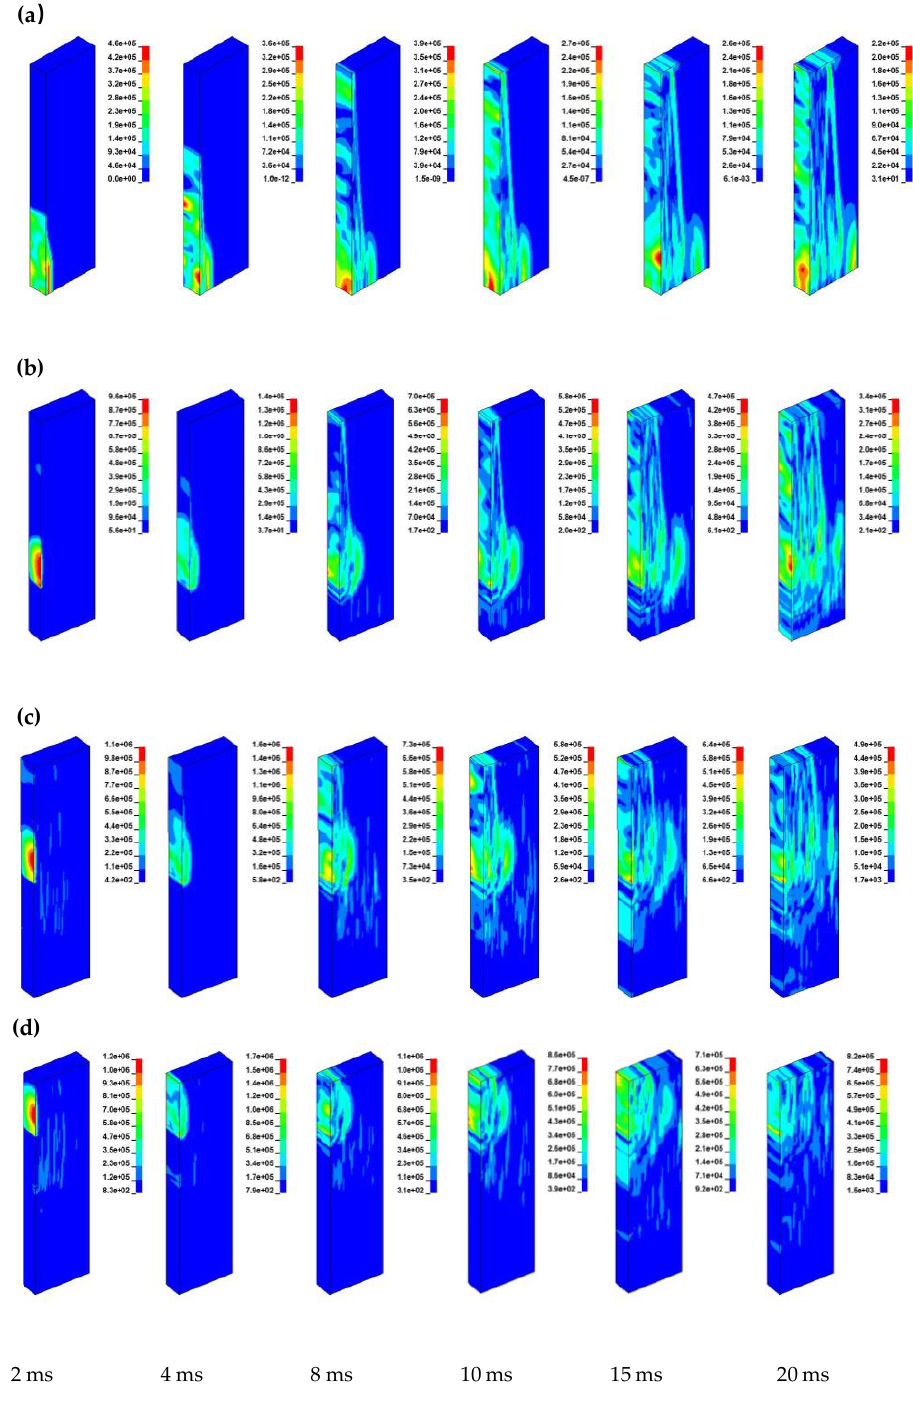
Figure 8. Stress evolution in the CPB stope induced by blasting in an adjacent ORE stope: ( a ) the first lift blast; ( b ) the secondary lift blast; ( c ) the third lift blast; ( d ) the fourth lift blast.